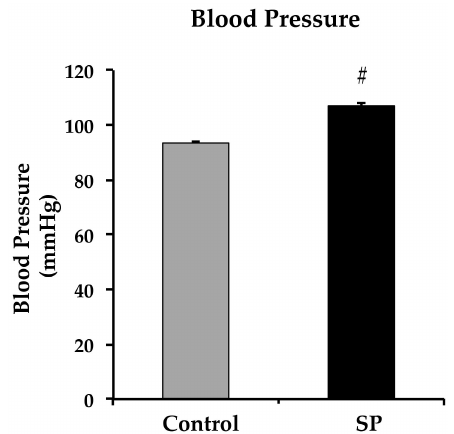
Figure 1. Changes in blood pressure in control and sucrose period rats. # p ≤ 0.05. n = 6, from 2 different litters. Data represent mean ± SEM, # p < 0.05.